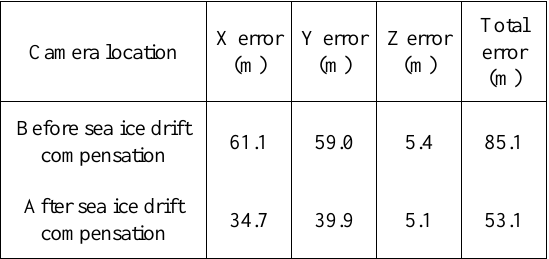
Figure 5. Quality assessment of locations of photos taken during mosaicking: (a) errors from camera location estimation before sea ice drift compensation and (b) errors from camera location estimation after sea ice drift compensation. Table 1. Quality assessment of camera locations before and after sea ice drift compensation.